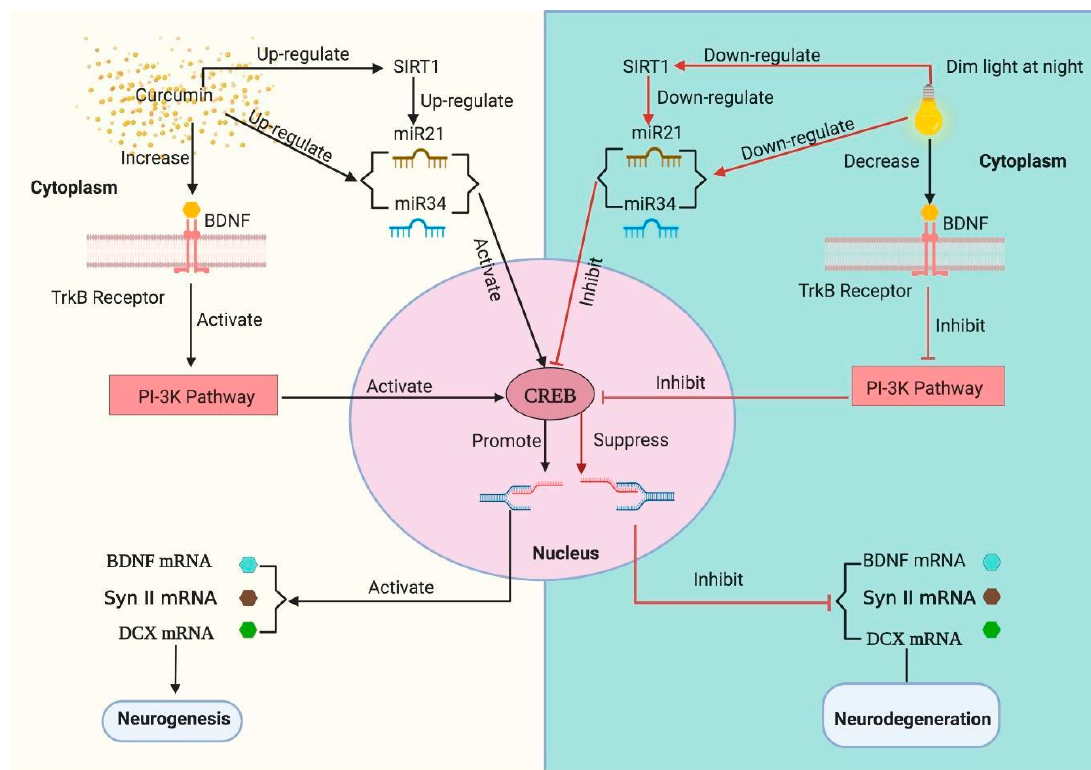
Figure 1. In the mice exposed to dim light (5 lux) at night (dLAN), reduction of the brain-derived neurotrophic factor (BDNF) protein led to down-regulation of tyrosine kinase B neurotrophic receptor (TrkB). This leads to down-regulation of the phosphoinositide 3-kinase (PI3K) pathway and deactivation of the transcription factor cyclic AMP response-element binding protein (CREB). Since CREB is responsible for the production of BDNF, Synapsin II, and DCX proteins, inhibition of these transcripts leads to neurodegeneration. Further, in the dLAN-exposed group, the reduction of the SIRT1 gene down-regulates the miRNA21a-5p and miRNA34a-5p which inhibits the CREB pathway. Curcumin treatment increases the hippocampal BDNF protein which leads to up-regulation of TrkB neurotropic receptor, activation of PI3K pathway and transcription of CREB. The activation of CREB transcript leads to neurogenesis and improvement of learning and memory. The expression of miRNA21a-5p and miRNA34a-5p also increased in the curcumin treated groups. which leads to up-regulation of the downstream products including TrkB and CREB.